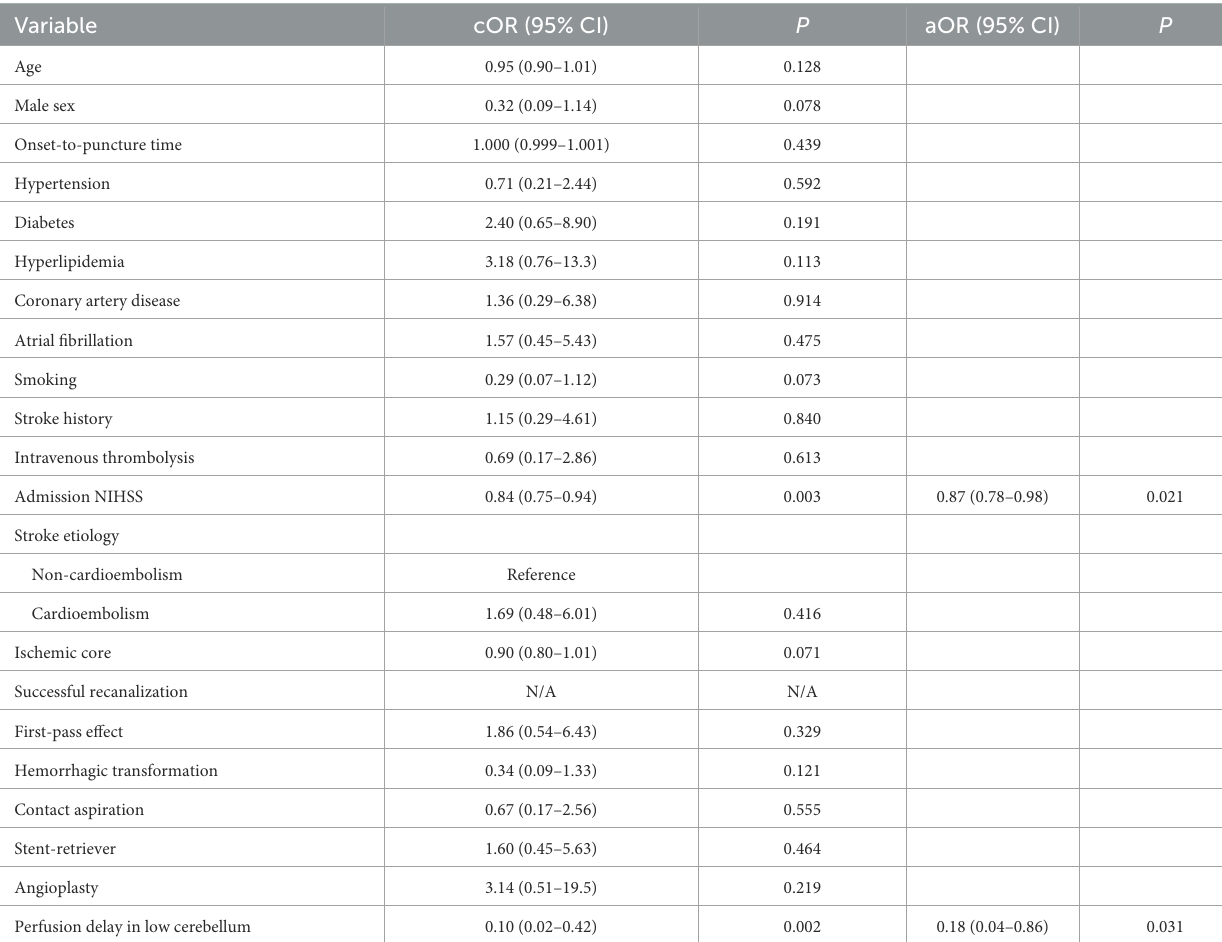
TABLE 2 Factors associated with mRS scores of